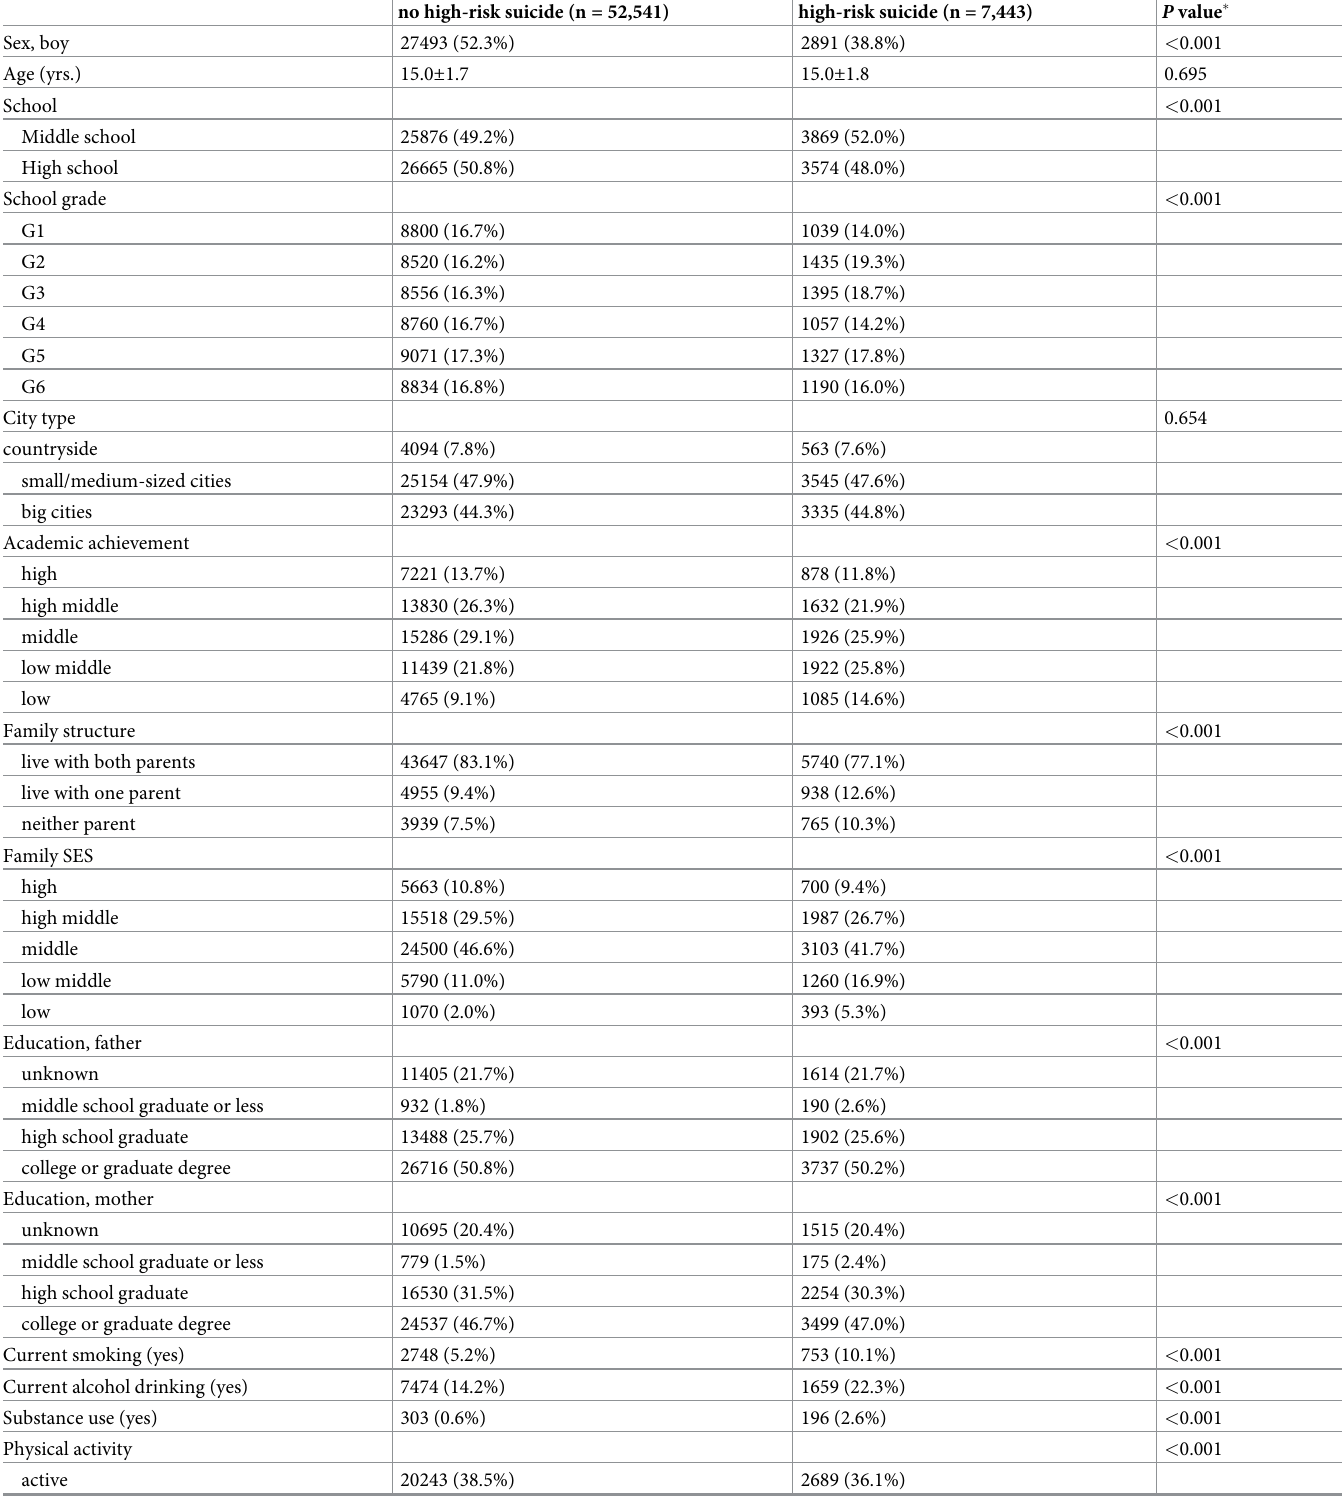
Table 2. Characteristics of high-risk suicide ( n = 7,443) and no high-risk suicide ( n =